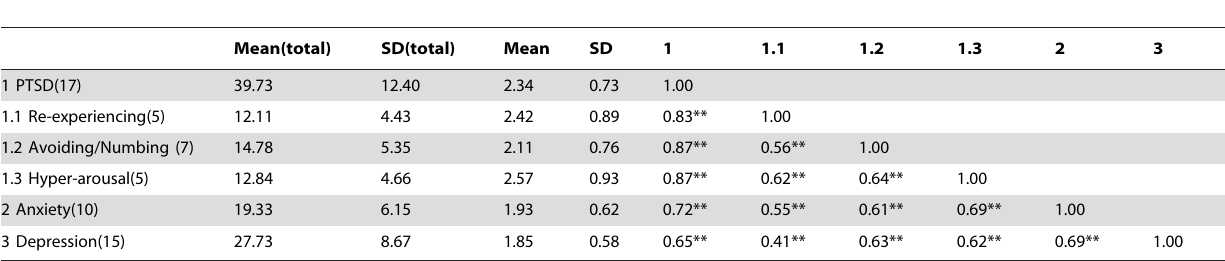
Table 2. Descriptive statistics and correlations of the severity of PTSD, anxiety and depression